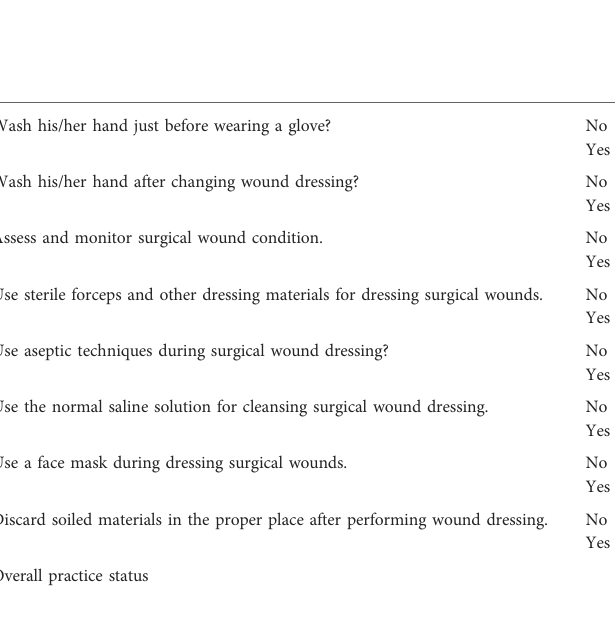
TABLE 4 Actual and self-reported surgical site infection prevention practice status among nurses working at public hospitals in the western part of SNNPR, Ethiopia 2020, ( n =402). Practice questions ( n =